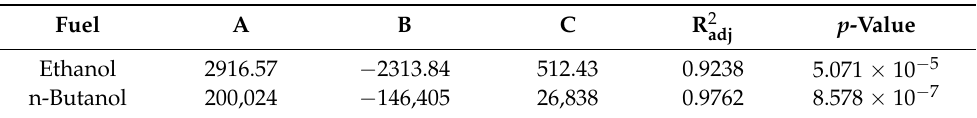
Figure 9. ( a ) Regression function of ethanol–diesel fuel lubricity as a function of kinematic viscosity; ( b ) regression function of n-butanol–diesel fuel lubricity as a function of viscosity. Purple area highlights exceeding the limit given by the standard.